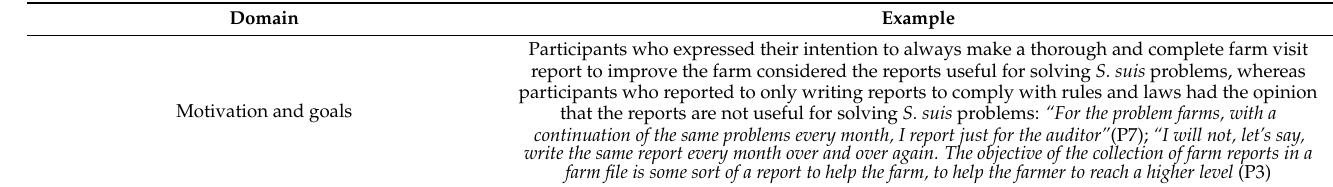
Table A3. Examples of determinants in domains that were incidentally mentioned in the study: “Why Veterinarians (Do Not) Adhere to the Clinical Practice Streptococcus suis (S. suis) in Weaned Pigs Guideline: A Qualitative